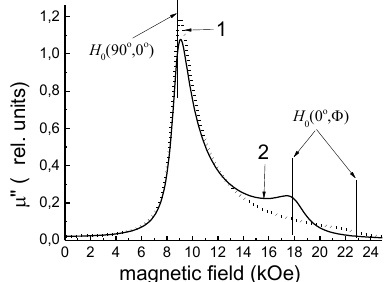
Fig. 1. Resonance curves of polycrystalline hexaferrite with EMP. Curve 1 (points): anisotropy fields H a1 = – 10 kOe, H a2 = H a3 = H Φ =0 kOe. Curve 2 (line): anisotropy fields H a1 = – 5 kOe, H a2 = – 5 kOe, H a3 = H Φ =0 kOe.